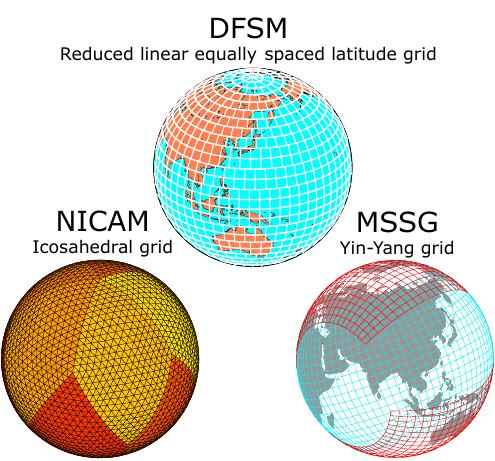
Figure 1. Schematic diagram of the horizontal grid structures of the three models used in